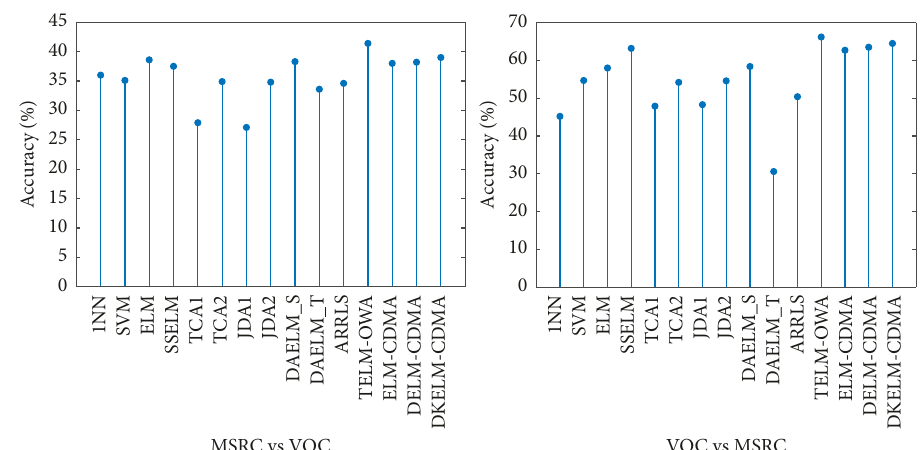
Figure 8: Classification accuracy of different algorithms on MSRC +VOC data set.